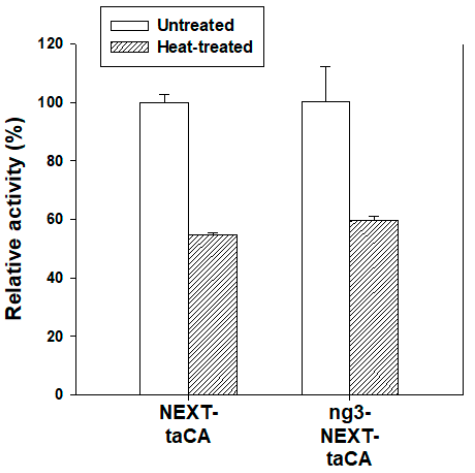
Figure 2. Effect of fusion of ngCA-derived peptide tags to NEXT-taCA. ( a , c ) Expression analysis of modified NEXT-tag-fused taCA by SDS-PAGE followed by Coomassie blue staining. The arrow indicates the band position of recombinant proteins. Western blot was performed using an anti-His 6 antibody. Lanes: MW, molecular mass marker; T, total cell lysate; ( b , d ) Relative CO 2 hydration activities of whole-cell lysates. Error bars represent standard deviations from two independent experiments.